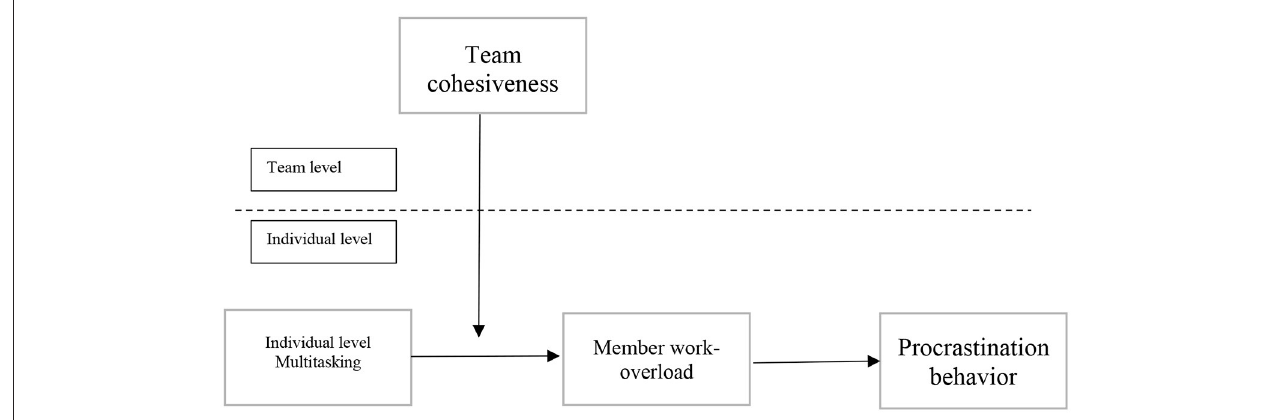
FIGURE 1 | Multilevel